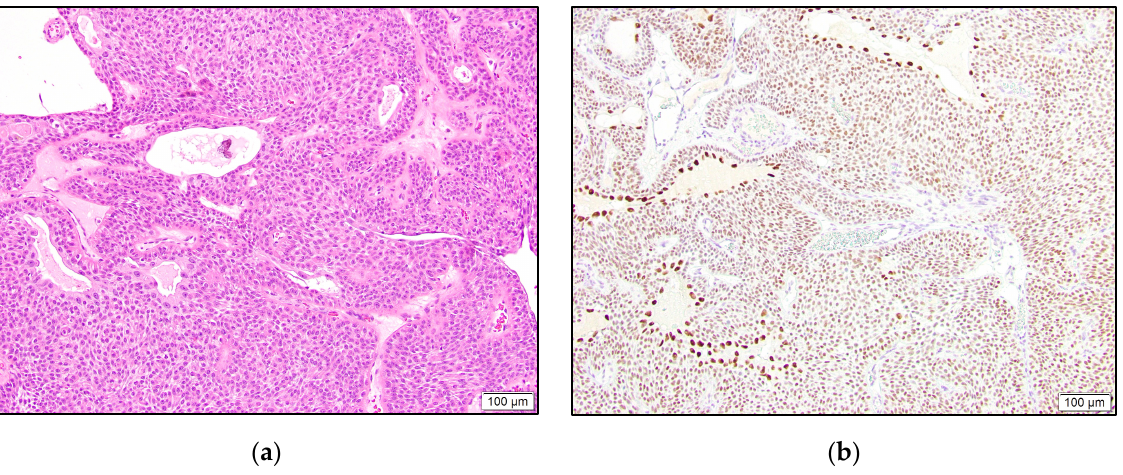
Figure 4. Hidradenoma with solid and cystic areas composed of eosinophilic cells and focal clear cells ( a ) and TRPS1 expression with accentuated staining in cells lining cystic spaces ( b ). In the poroma group, six and two cases demonstrated intermediate to high and low positivity, respectively (Figure 5). One poroma was negative for TRPS1 expression. In the majority of the positive cases, variable staining intensity was present in the tumor cells. This finding was more evident in the hidradenomas. All MAC and syringoma cases were negative for TRPS1 expression (Figure 6). The majority of the cylindroma and spiradenoma cases showed distinctive staining patterns and were not categorized by the abovementioned reporting system. Only one spiradenoma was completely negative. The remaining two spiradenomas and all seven cylindromas revealed the strongest staining in the luminal cells and relatively weaker or negative staining in the surrounding neoplastic cells. The outermost layer with palisading cells was mostly negative for TRPS1 expression (Figure